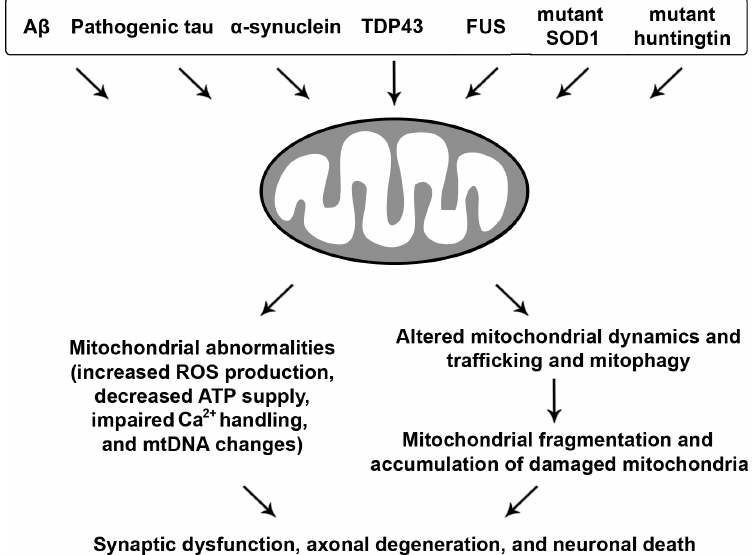
Figure 3. Neurodegenerative disease-associated mitochondrial toxicity. Misfolded proteins, oligomers, protein aggregates, or fibrils linked to major neurodegenerative diseases induce mitochondrial abnormalities, leading to increased reactive oxygen species (ROS) levels, loss of mitochondrial membrane potential ( Δ ψ m ), decreased oxidative phosphorylation (OXPHOS) and ATP production, impaired Ca 2+ buffering, and enhanced mitochondrial DNA (mtDNA) changes. Moreover, impairments in mitochondrial dynamics and tra ffi cking as well as mitophagy result in excessive mitochondrial fission and fragmentation and aberrant accumulation of dysfunctional mitochondria, all of which collectively contribute to synaptic dysfunction, axonal degeneration, and neuronal